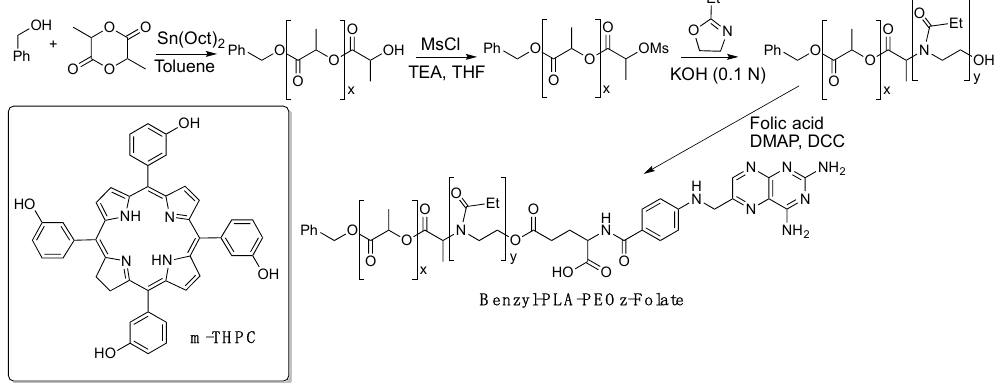
Figure 5. Synthetic strategy for folate-conjugated PEOz-PLA copolymer used to prepare pH-responsive micelles to encapsulate m -THPC.